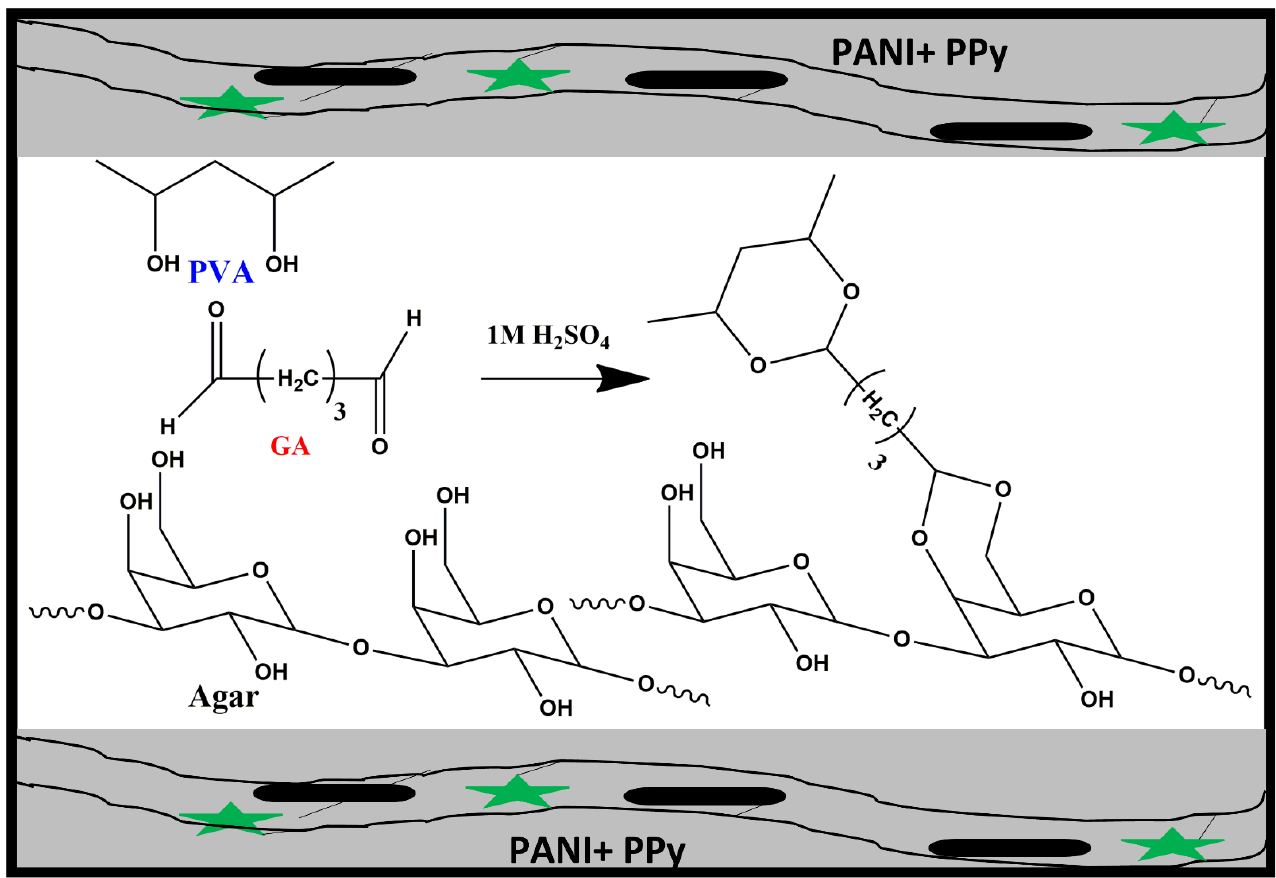
Figure 4. The in situ polymerization mechanism of electrode material (Top and bottom chains represent the PANI + PPy where green stars show PANI and bold lines reveal PPy)